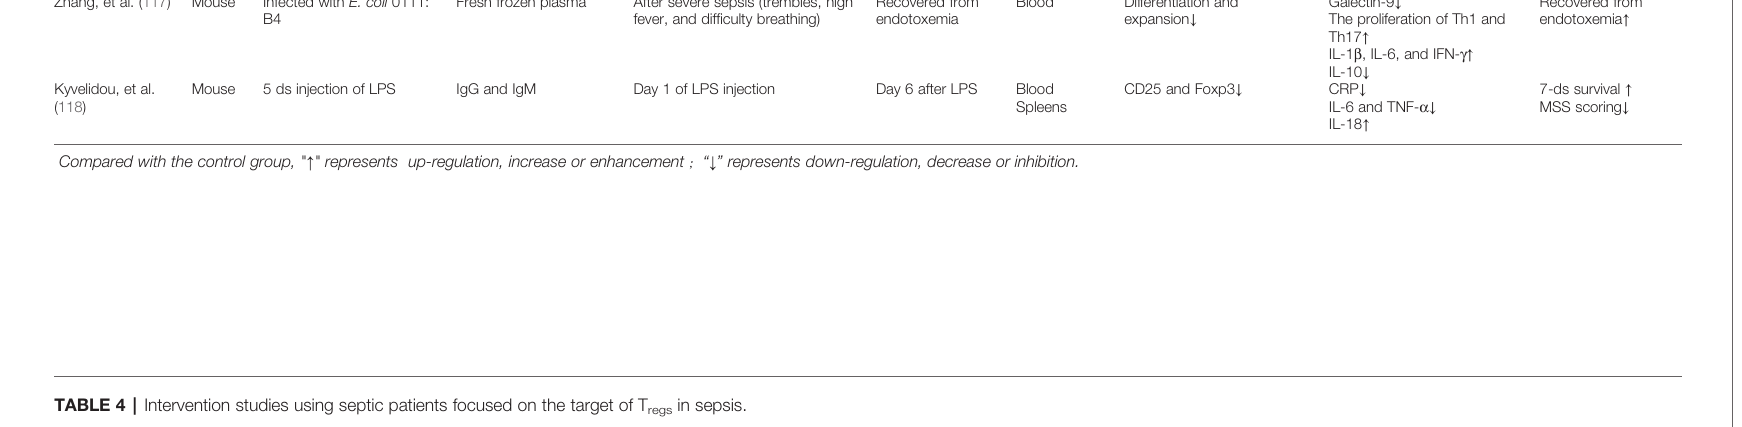
TABLE 4 | Intervention studies using septic patients focused on the target of T regs in sepsis. Intervention study Species